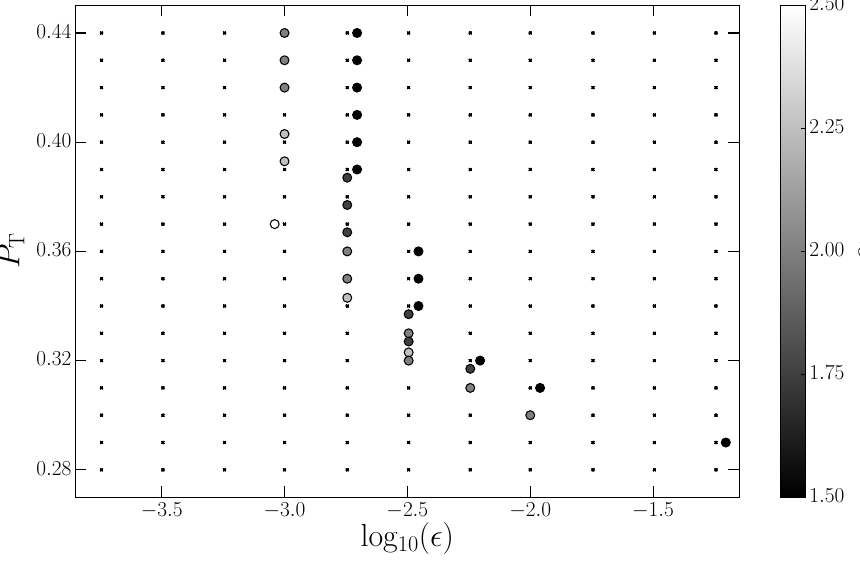
Fig. 4. 3-D parameter space of the models shown in Fig. 3. The gray-shaded circles indicate the values of α parameter. The small black points at each node of the model grid indicate a fully explored extent of the parameter